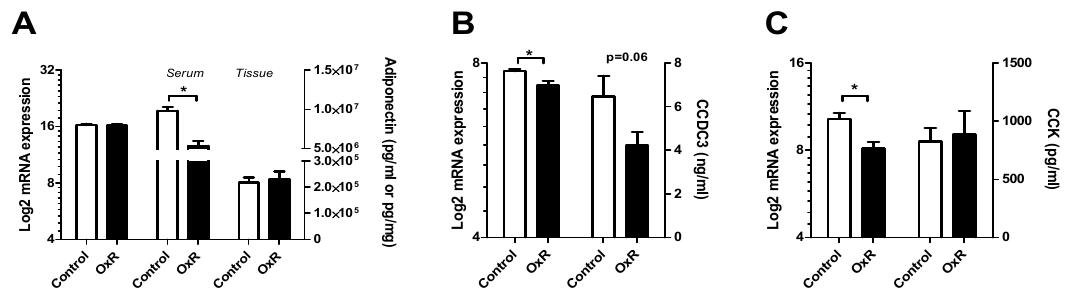
Figure 7. White adipose tissue (WAT) metabolism-associated transcript and protein expression levels and corresponding serum levels. ( A ) Adiponectin levels, ( B ) coiled-coil domain containing 3 (Ccdc3) levels, and ( C ) cholecystokinin (Cck) levels as analysed by transcript levels using gene expression microarrays (left), their serum levels (middle / right), and their tissue level. Open bar: control, closed bar oxygen restriction (OxR) mice. Data are shown as mean ± SEM (n = 8–10). * p < 0.05.